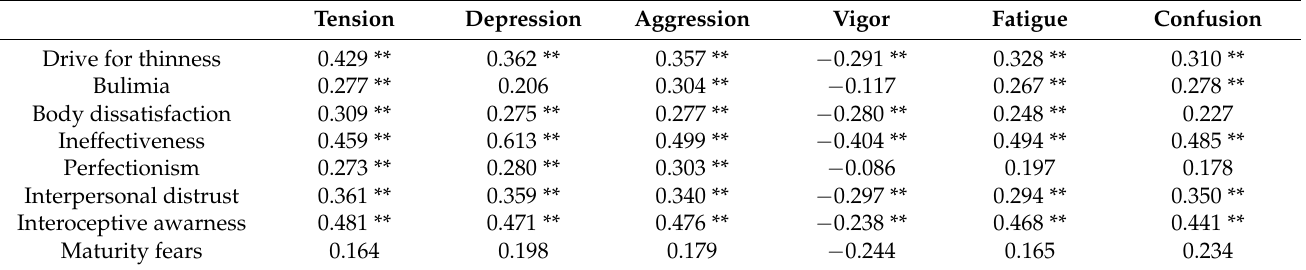
Table 2. Correlations between negative emotions (POMS) and eating behavior among females (N = 138). Tension Depression Aggression